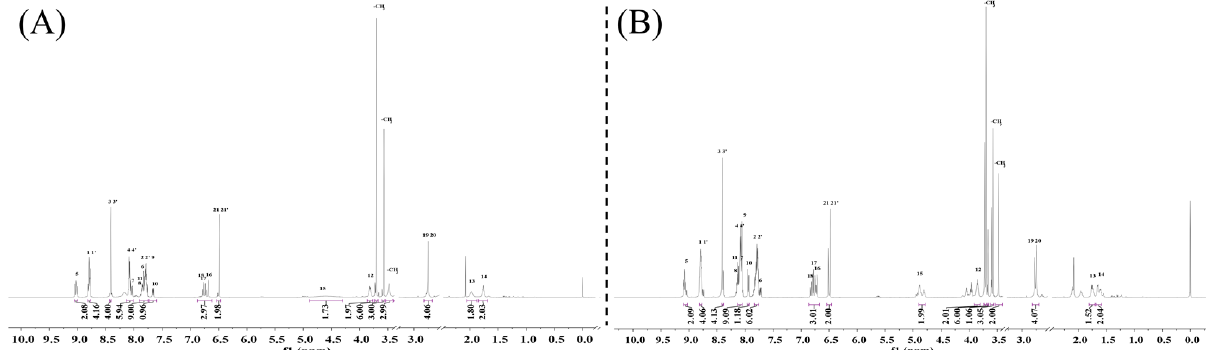
Figure 1. The 1 H NMR spectra of 1 ( A ) and 2 ( B ).